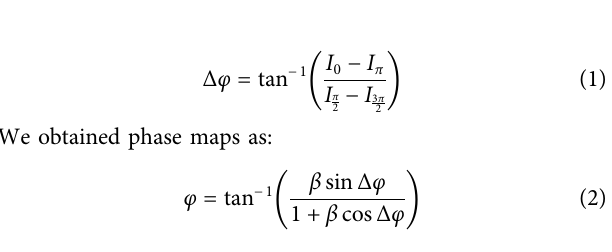
FIGURE 1 | Schematic of the instrumentation platform consisting of optical tweezers and quantitative phase imaging system. BE: Beam expander, BS: Beam splitter,ML:Mercurylamp,TM:Mirroronaturret,L:focusinglens( f (cid:1) 25 mm),BP:bandpass fi lter,QPD:Quadrantphotodiode,DM:Dichroicmirror,FC:Filtercube,MO: Microscope objective, PZT: Piezo-electric translation stage, CL: Condenser lens, CA: Condenser annulus, HL: Halogen lamp, P: polarizer, M: Mirror, SLM: Spatial light modulator,L1andL2:achromaticdoublets( f (cid:1) 500